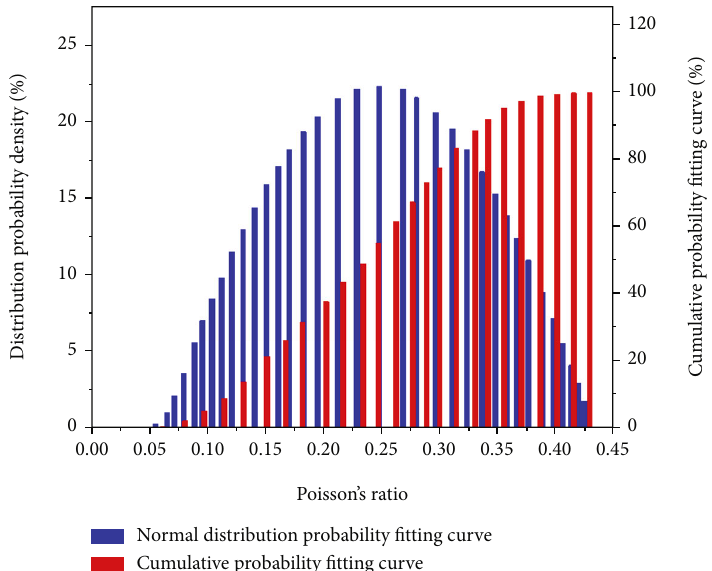
Figure 5: Probability distribution and fi tting curve of Poisson ’ s